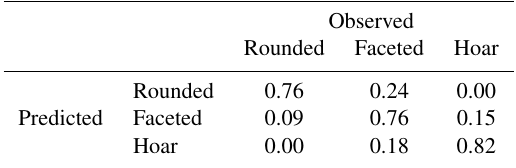
Table 3. Normalized confusion matrix for the support vector ma- chine (SVM) layer-type classification of SMP profiles compared against known snow pit samples. Results were 10-fold cross- validated and samples were stratified to ensure a minimum of 10 samples per layer-type class in each